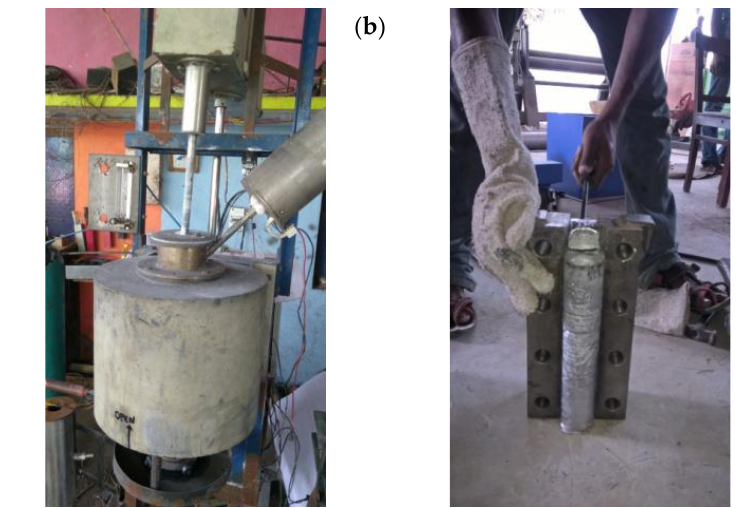
Figure 2. Equipment setup: ( a ) vacuum casting setup ( b ) fabricated composites.